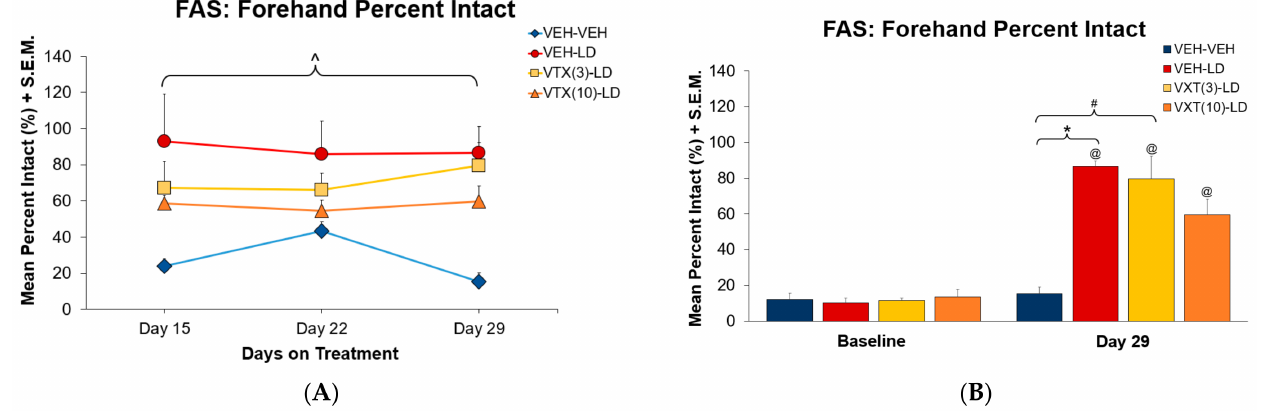
Figure 4. Experiment 1: Effects of Chronic Vortioxetine Intervention on Forehand Motor Performance. Rats (N = 26) were treated with vortioxetine (VTX; 3, 10 mg/kg, s.c.) or vehicle (VEH) 5 min prior to administration of L-DOPA (LD; 6 mg/kg, s.c.) or VEH (n = 6 VEH-VEH; n = 6 VEH-LD; n = 7 VTX(3)-LD; n = 7 VTX(10)-LD). At 60 min into each abnormal involuntary movements (AIMs) session, the forepaw adjusting steps (FAS) test was employed to evaluate motor performance. Forehand motor performance was expressed as forehand percent intact values ([number of lesioned forepaw steps/number of non-lesioned forepaw steps] × 100). FAS data is shown as mean percent intact and standard error mean (S.E.M.). Analysis of FAS measures across the 2 week period ( A ) were determined using 3 × 4 mixed-model ANOVAs. ˆ p < 0.05 VEH-LD and VTX(3)-LD vs. VEH-VEH. Final day 29 testing ( B ) were determined using 2 × 4 mixed-model ANOVAs. * p < 0.05 VEH-VEH vs. VEH-LD; # p < 0.05 VEH-VEH vs. VTX(3)-LD; @ p < 0.05 Any treatment vs.